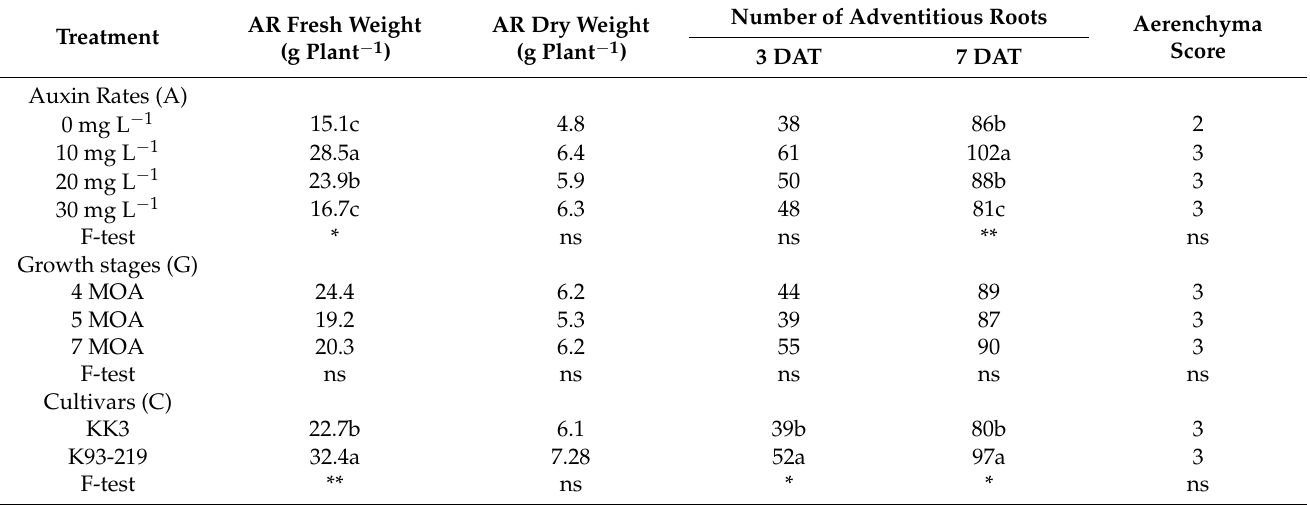
Table 7. Adventitious root development of two sugarcane cultivars as affected by auxin application rates at different growth stages at the end of the flooding treatment period, Experiment